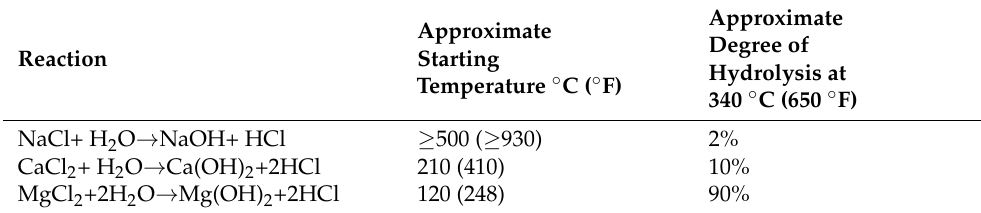
Table 1. Hydrolysis reactions in the atmospheric distillation column of crude oil.